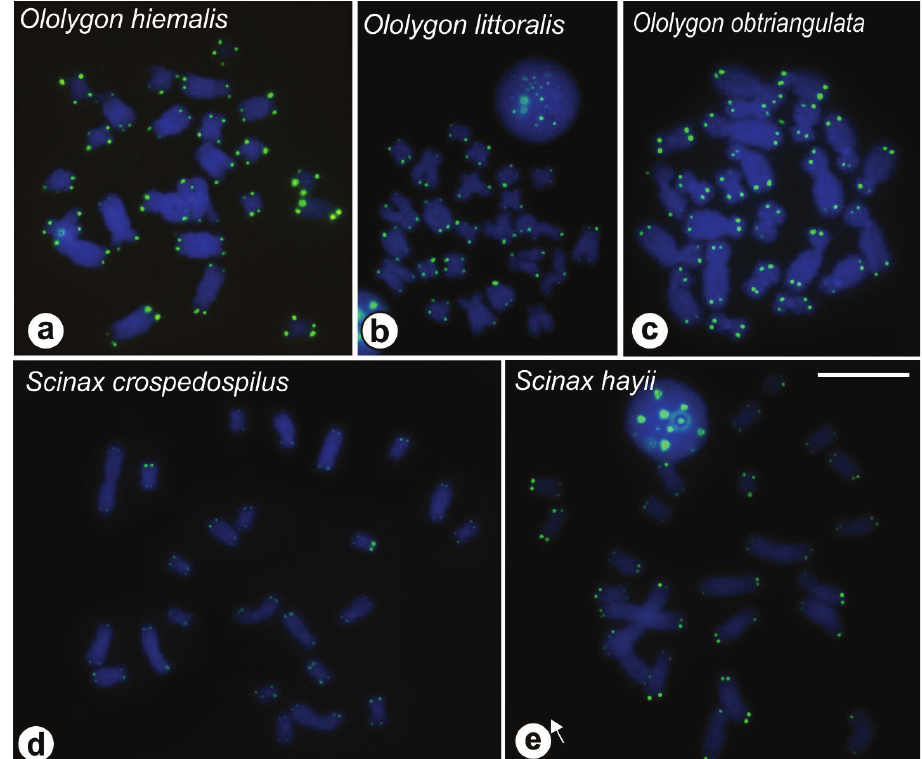
Figure 5. FISH with telomeric probes in Ololygon and Scinax species. a O. hiemalis b O. littoralis c O. obtriangulata d S. crospedospilus e S. hayii. Bar = 10